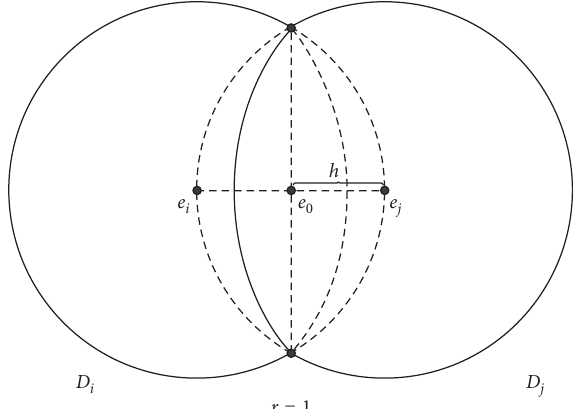
Figure 1: Two adjacent unit balls with centers e d ( e , e ) � 1. i j